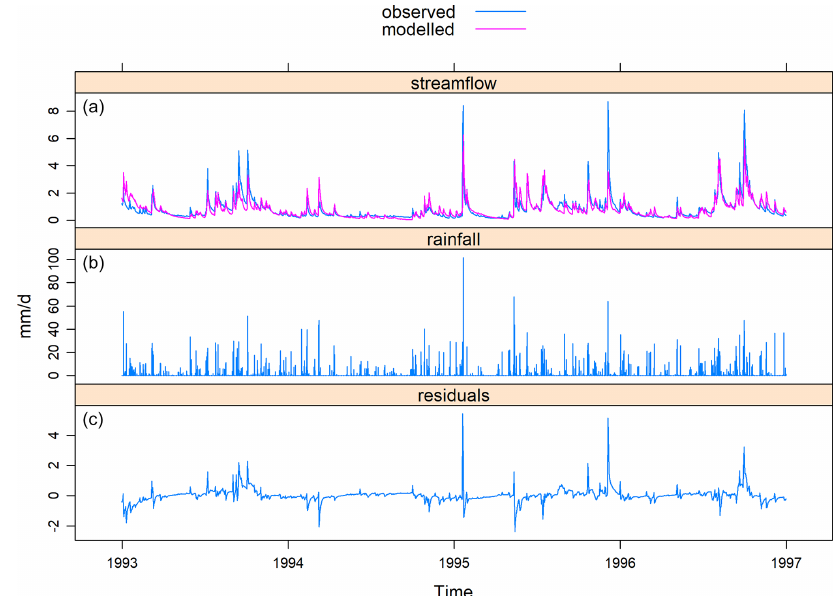
Figure A3. Example of plots enabled by the hydromad package. This example was generated by using one of the data sets included in the package and simulations with the IHACRES-CMD model. From top to bottom: observed and simulated hydrographs; precipitation time series; flow error (or residuals). These charts can be visualised with a log scale.